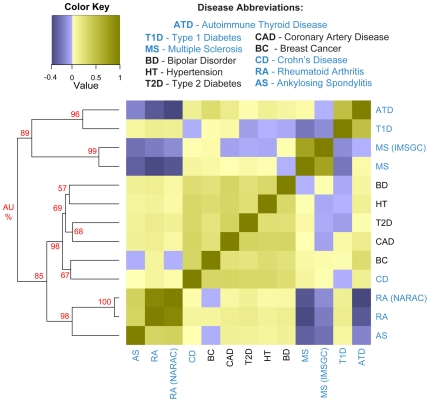
Disease heatmap based on genetic variation profiles.This diagram shows correlations between disease genetic variation profiles. Positive relationships between a pair of diseases are shown in brown, negative relationships are shown in purple. The diseases highlighted in blue have an autoimmune component. Hierarchical clustering using these correlations as a distance metric is shown on the left. Approximately Unbiased (AU) probability values (%) for each cluster indicating how strongly the cluster is supported by data are shown in red. Clusters with AU larger than 95% are strongly supported by data.